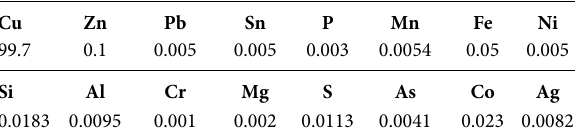
Table 2. Chemical composition of tool electrode (wt. %).